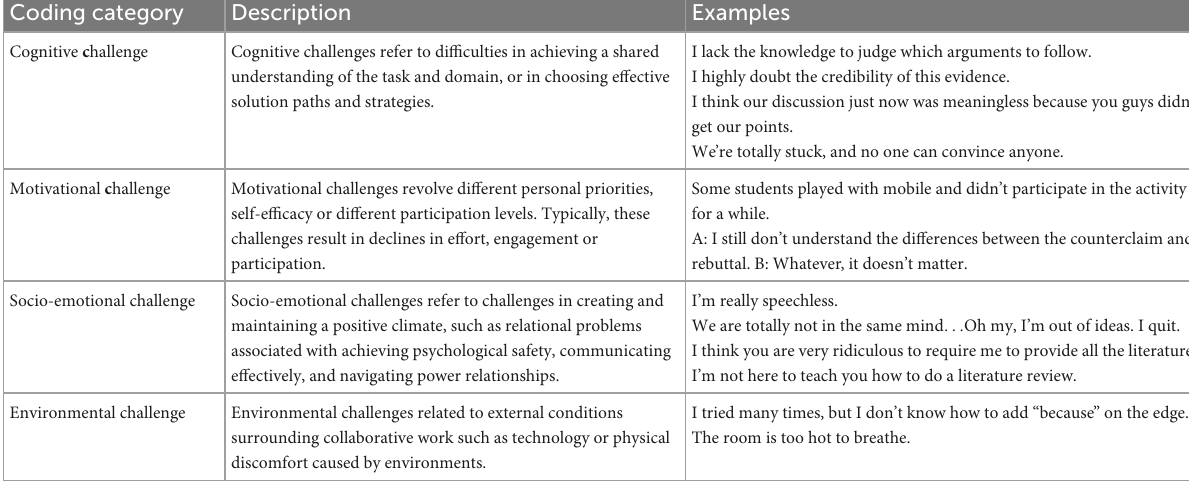
TABLE 1 Coding scheme for